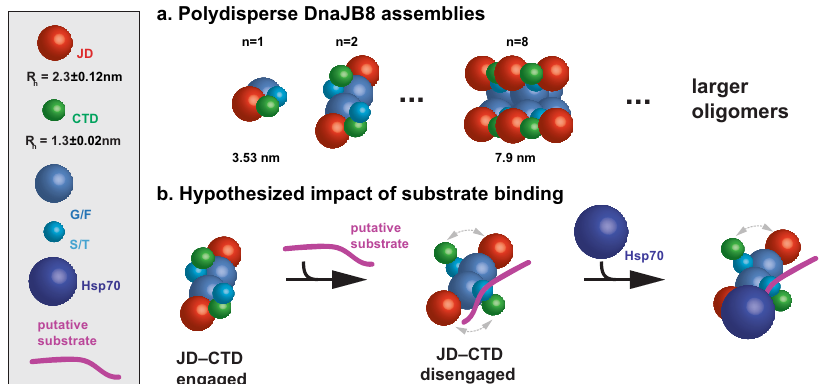
Fig. 7 Proposed model for DnaJB8 – HspA1A – substrate relationship. Schematic of proposed DnaJB8 model. Domains are shown as JD (red spheres), CTD (green spheres), G/F (blue spheres), S/T (light blue spheres), and also HspA1A (dark blue spheres) and substrate (purple line) are shown. DnaJB8 domain sizes are displayed scaled to the relative R h values derived from DLS experiments (HspA1A not drawn to scale). a DnaJB8 forms a fundamental oligomeric species through aromatic contacts in the G/F and S/T domains ranging from monomer to octamer. b The JD – CTD engaged state, where the JD is stabilized by CTD and helix 5 (G/F) contacts, can form larger polydisperse oligomers (>100 nm). The JD – CTD disengaged state (bottom) is needed to engage with HspA1A. We illustrate our hypothesis where substrate binding may allosterically disrupt the JD – CTD interaction to allow the recruitment of HspA1A to the freed JD – CTD binding face, enabling subsequent handoff of the substrate to